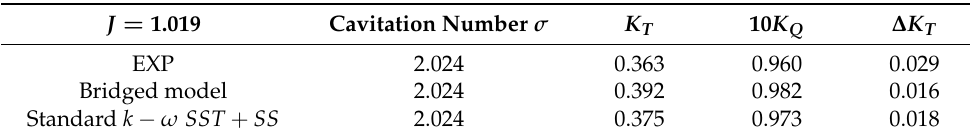
Table 10. Predicted cavitating propulsion